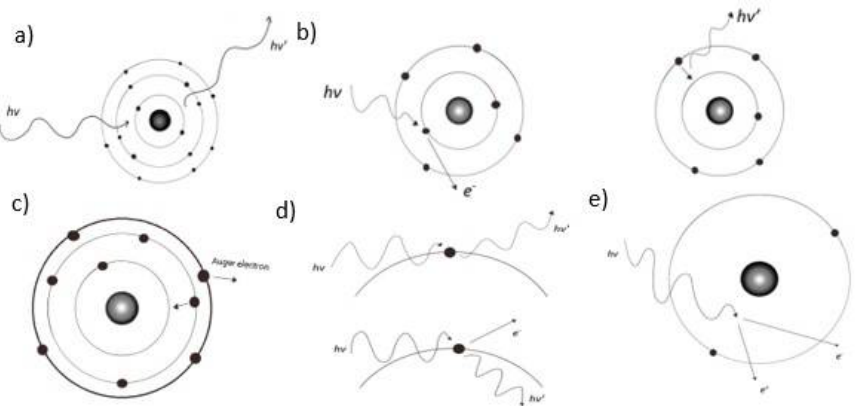
Figure 3. Schematic representation of Rayleigh scattering ( a ), the photoelectric effect ( b ), Auger effect ( c ), Compton scattering ( d ), and pair production ( e ).